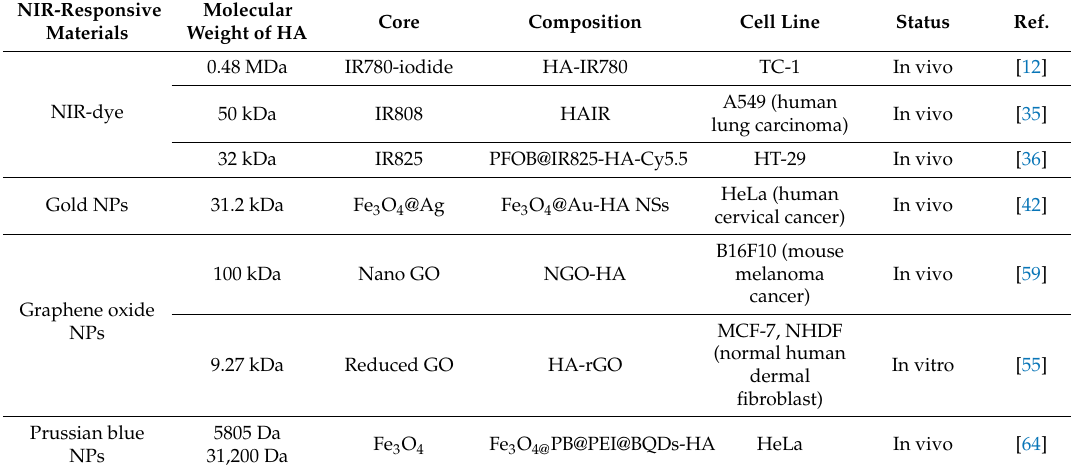
Table 1. Nanomaterials for hyperthermic cancer